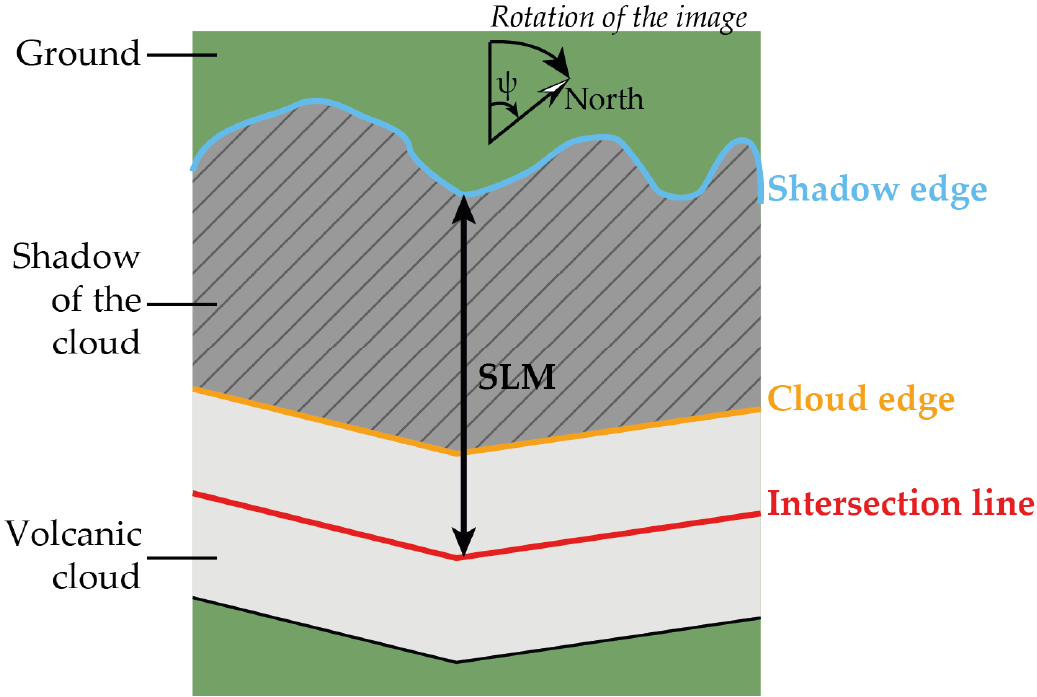
Figure 2. Schematic satellite view of the rotated plume / shadow system and parameter definition.